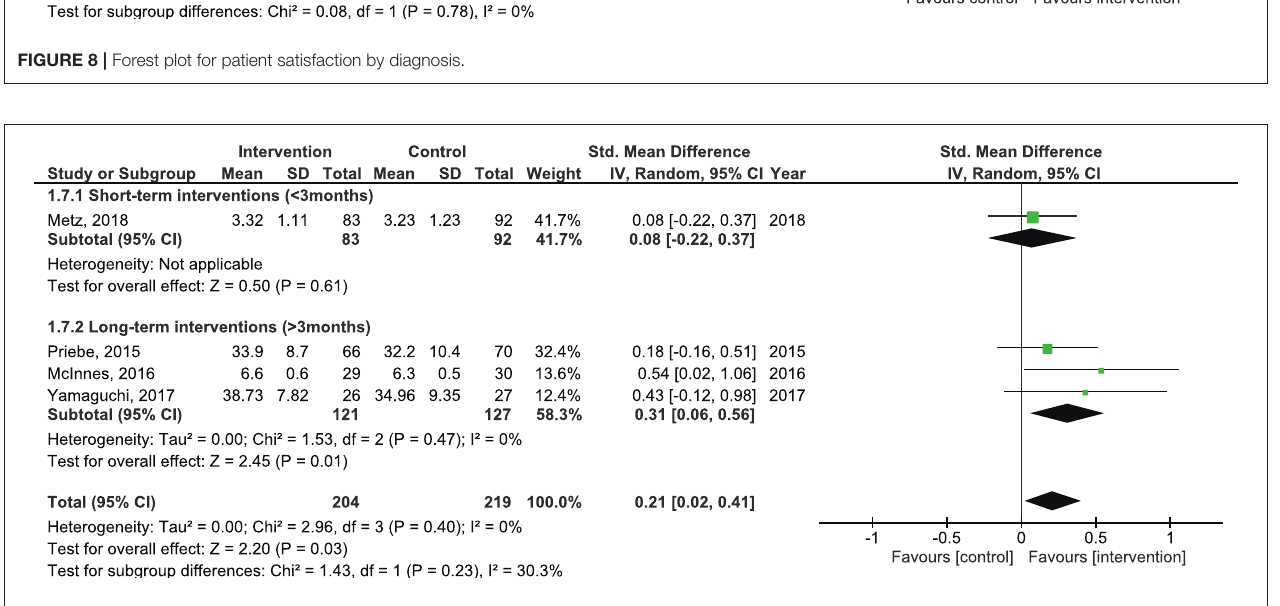
FIGURE 9 | Forest plot for working alliance by duration perceived by the